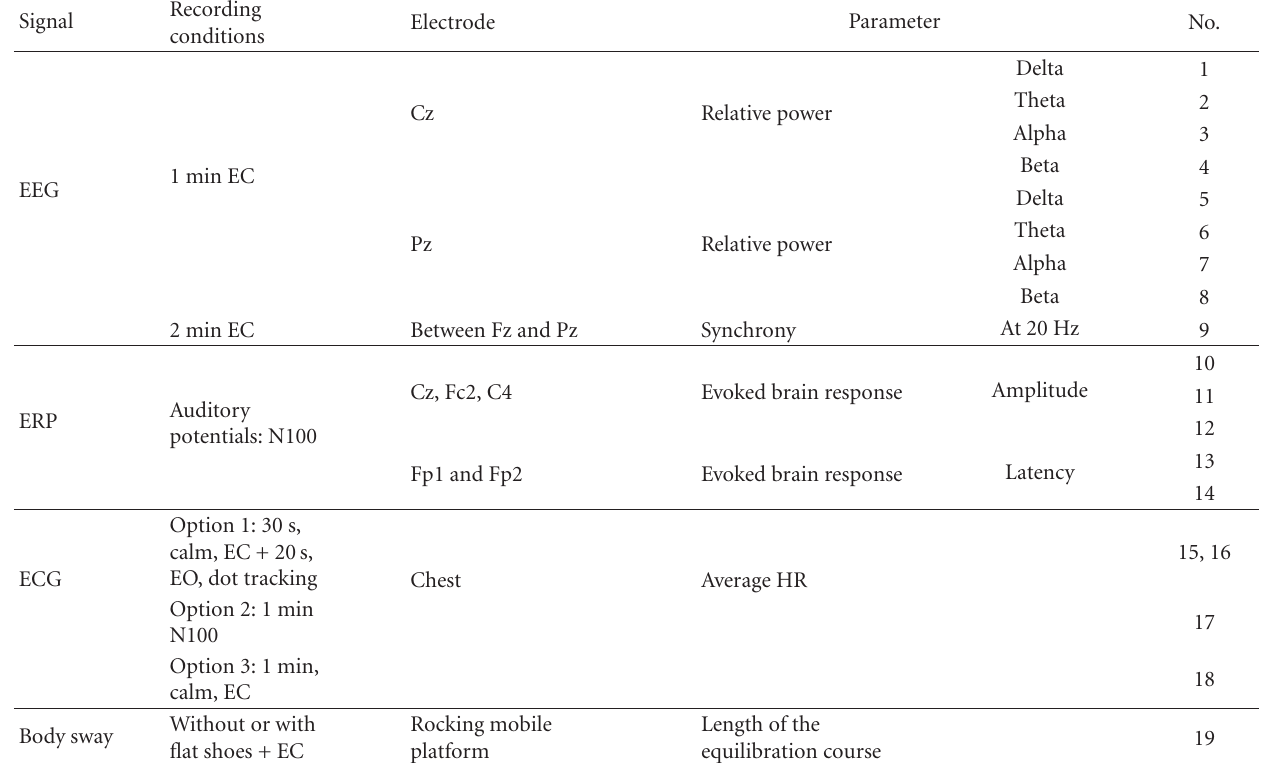
Table 1: Measurements and extracted features for the diagnosis of abnormal